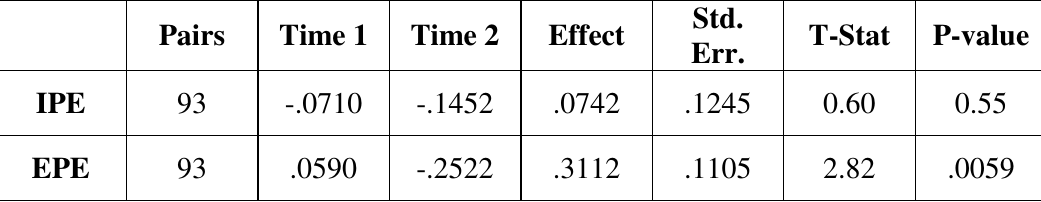
Table 6: PSM Results - IPE and EPE among Participants at Time 1 and Time 2 Pairs Time